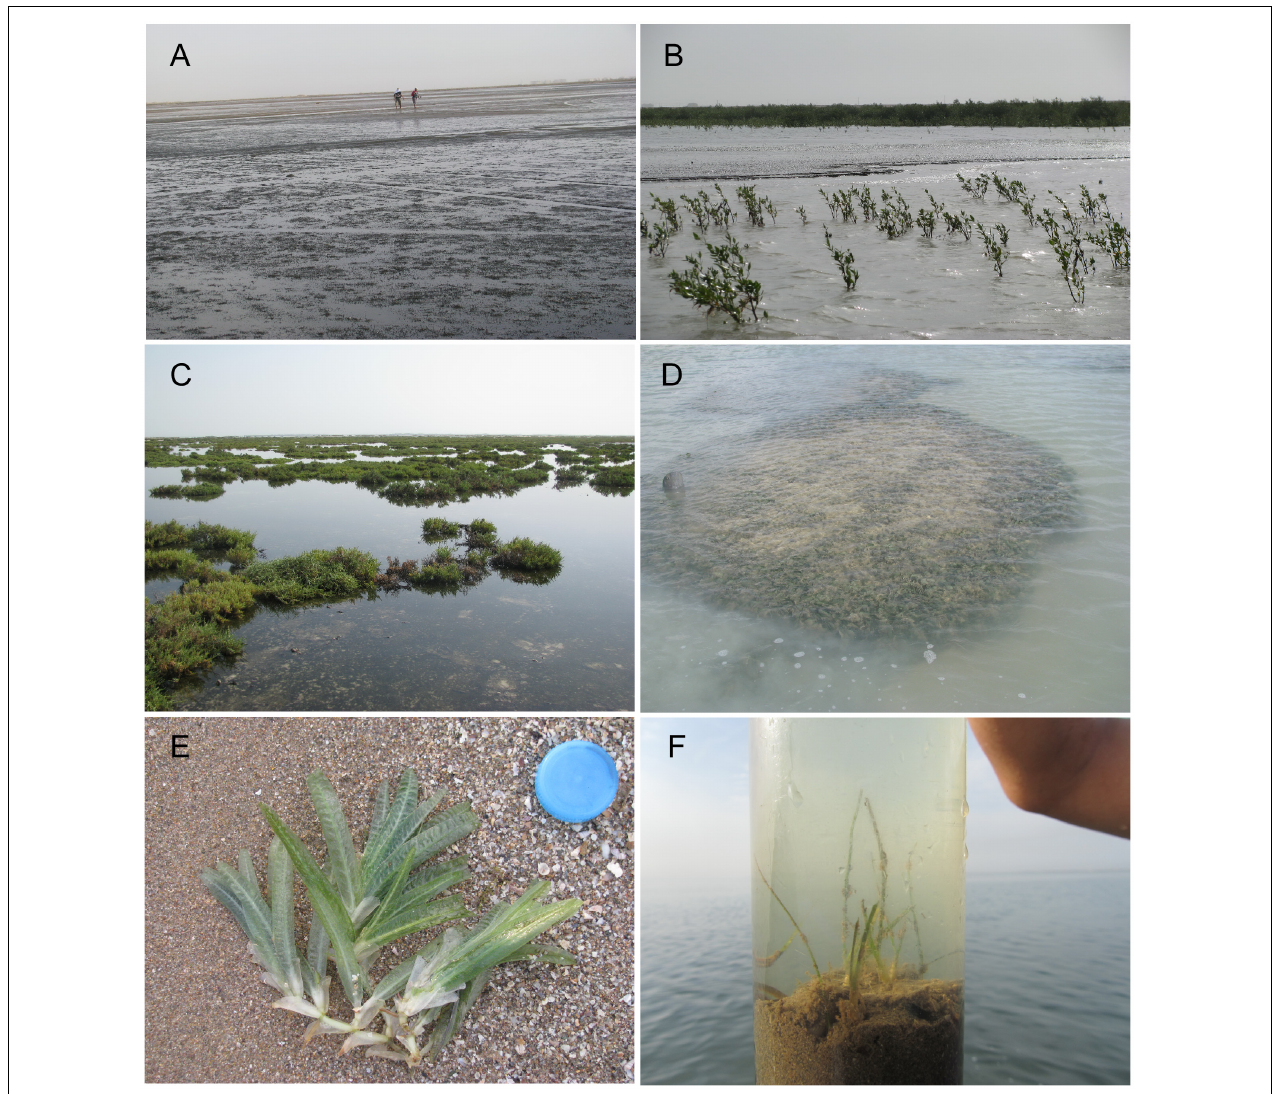
FIGURE 4 | The intertidal sabkha of Al-Kharrar Lagoon during high tide. (A) intertidal sabkha. (B) the mangroves Avicennia marina , (C) the coastal shrubs Salicornia fruticosa , (D) Avrainvillea cf. A. amadelpha , (E) the fan seagrass Halophila stipulacea , (F) the seagrass Cymodocea rotundata (Al-Dubai et al.,